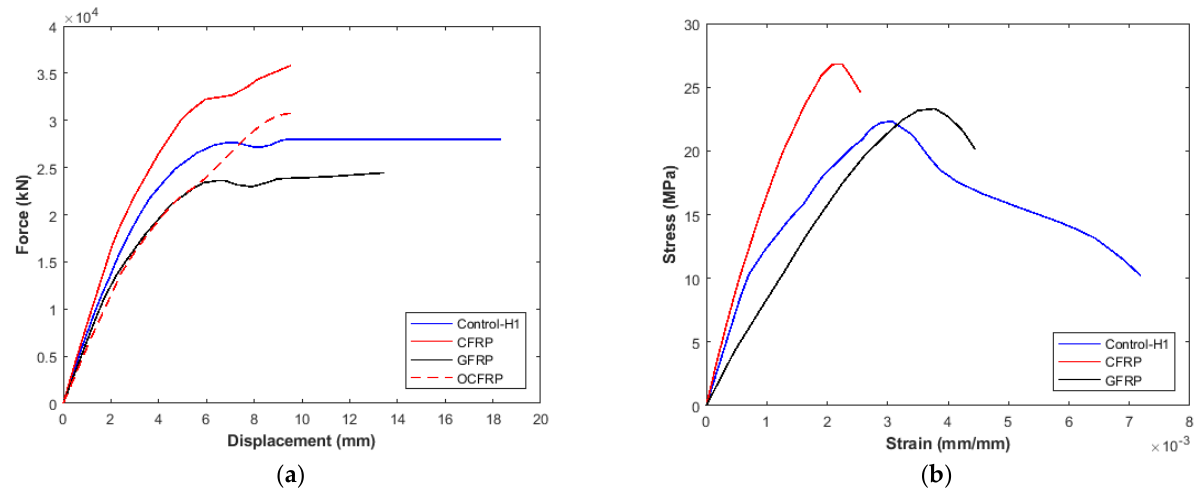
Figure 14. Group H ( a ) Load-Displacement diagram ( b ) Stress-Strain Diagram.